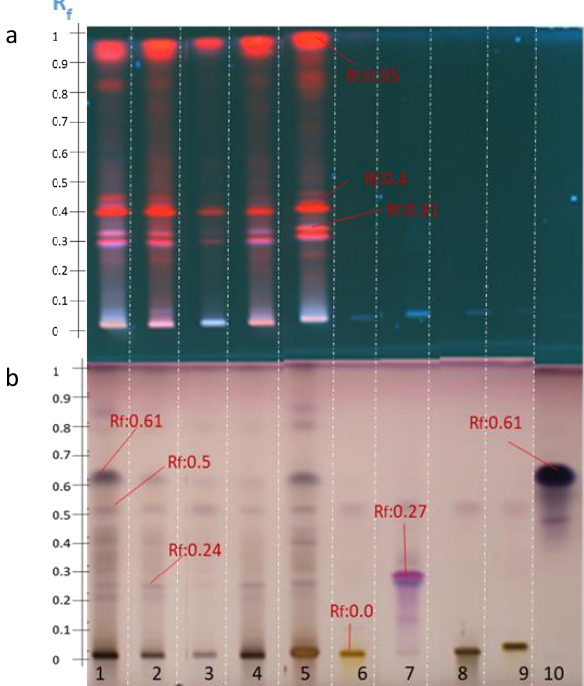
Figure 3. HPTLC profile obtained at 366 nm before visualization ( a ) and after visualization with anisaldehyde-H 2 SO 4 ( b ) of the 4 Zaghouan extracts according to the S1 elution system and P1 (Track 1), P2 (Track 2), P3 (Track 3), P4 (Track 4) and compared with M1 (Track 5) and the standards: Track 6, solanine; Track 7, senegenin; Track 8, digitonin; Track 9, glucose-fructose; Track 10, oleanolic acid.